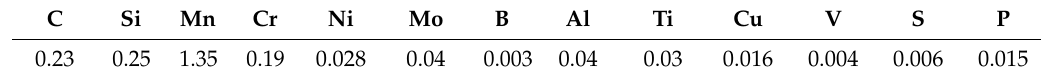
Table 1. Chemical composition of B1500HS steel (wt %).